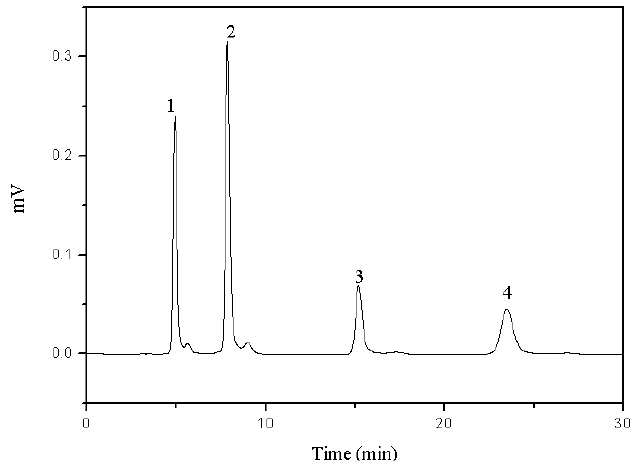
Figure 8. Chromatogram of the four target compounds with 0.01 mol/L of [EMIM][MS] as the mobile phase additive. 1: chlorogenic acid, 2: caffeic acid, 3: scoparone, 4: rutin.